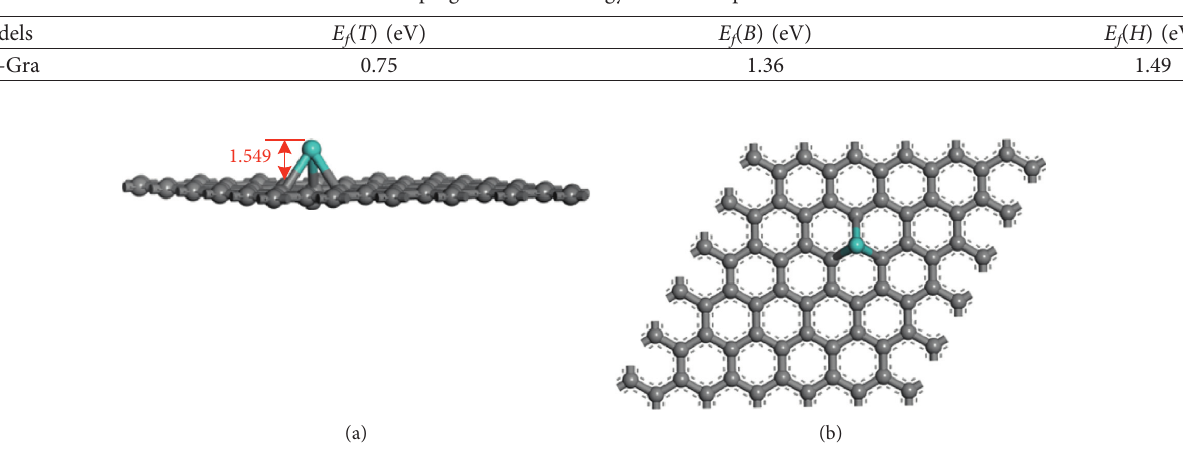
Table 1: Doping formation energy of Mo-Graphene surface.